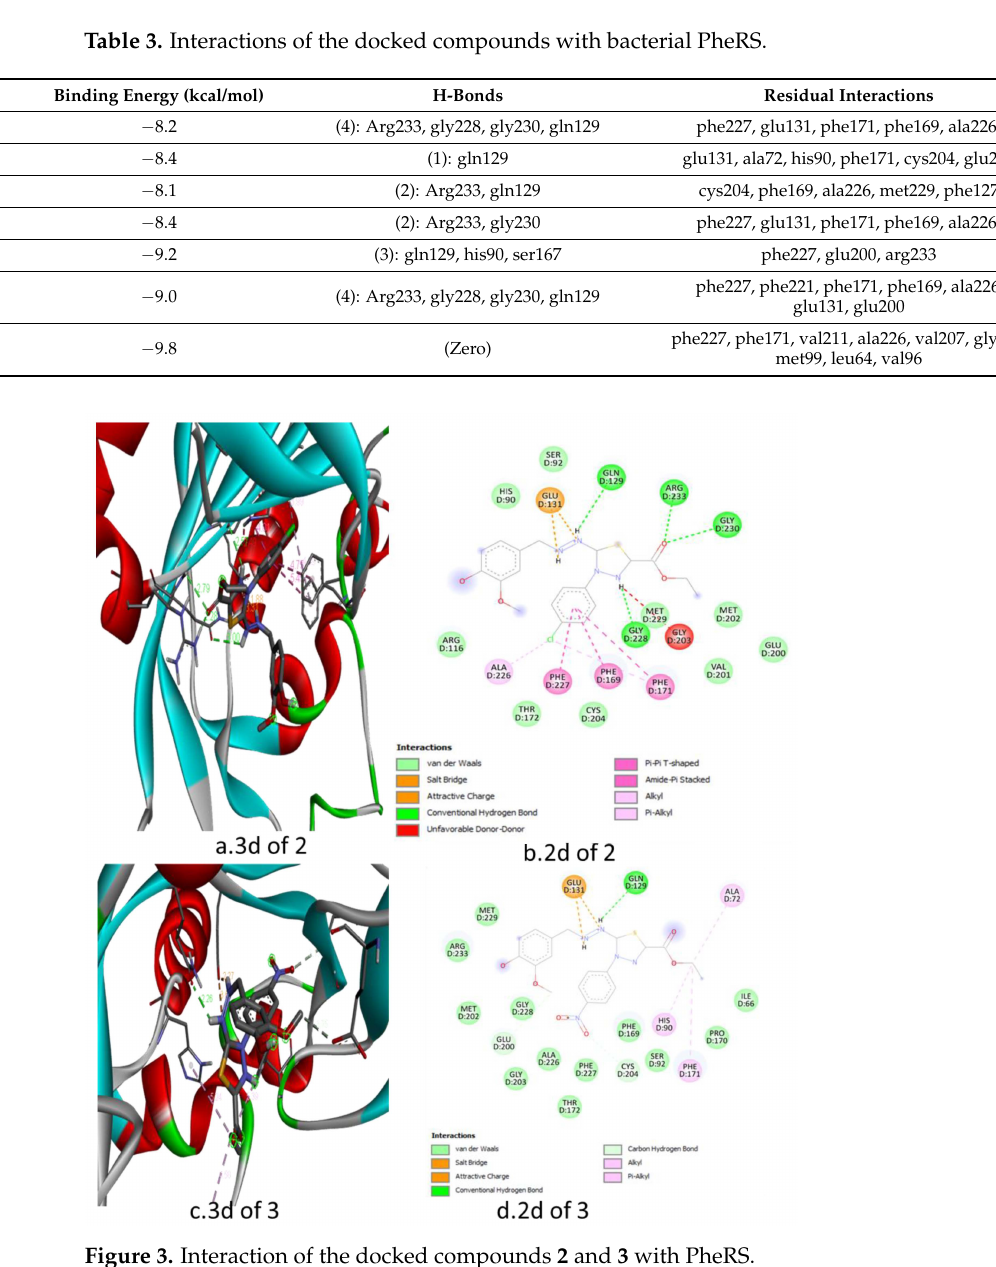
Figure 3. Interaction of the docked compounds 2 and 3 with